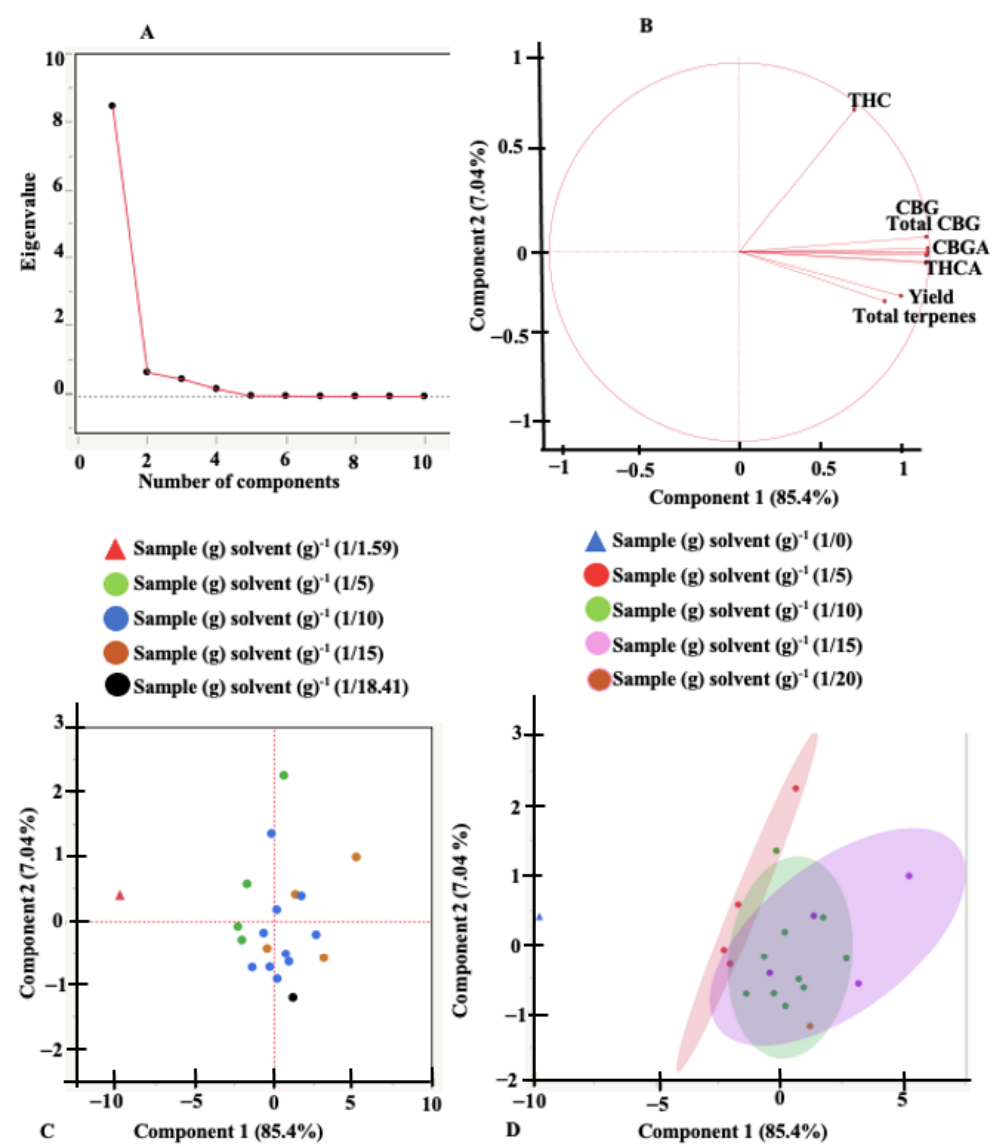
Figure 4. Principal component analysis plots. ( A ) scree plot, ( B ) loadings plot, ( C ) scores plot, and ( D ) scatterplot, for microwave-assisted extraction.